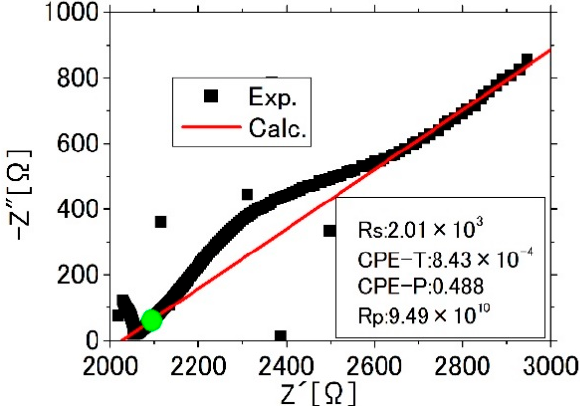
Figure 12. Cole–Cole plot from the impedance measurement for Ag electrode with the applied voltage of 2 V. The green circle shows the impedance at 224 Hz, closest to 222 Hz. The same equivalent circuit as in Figure 9b is assumed for fitting.